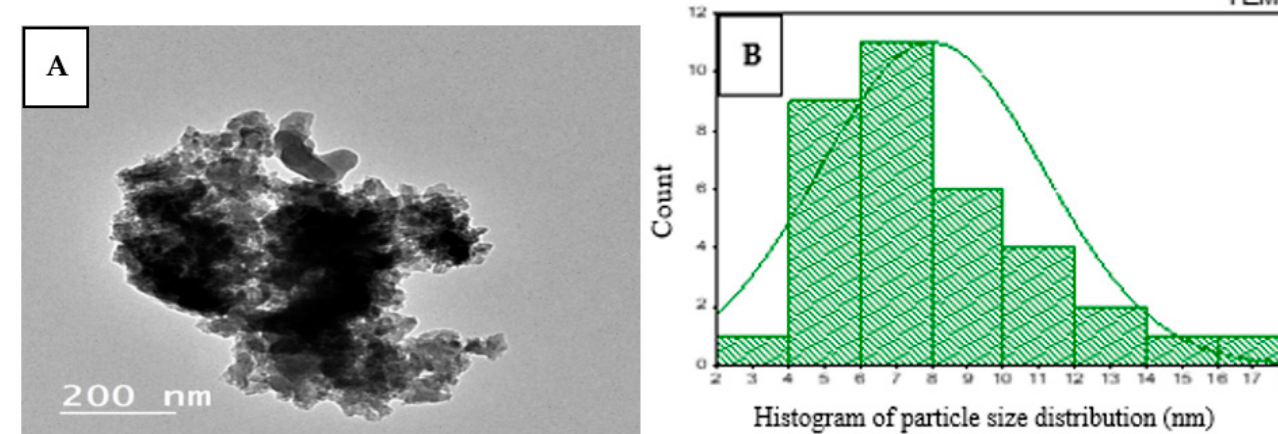
Figure 4. TEM image of Qi-ZnO-NPs ( A ) and a particle size distribution histogram ( B ).